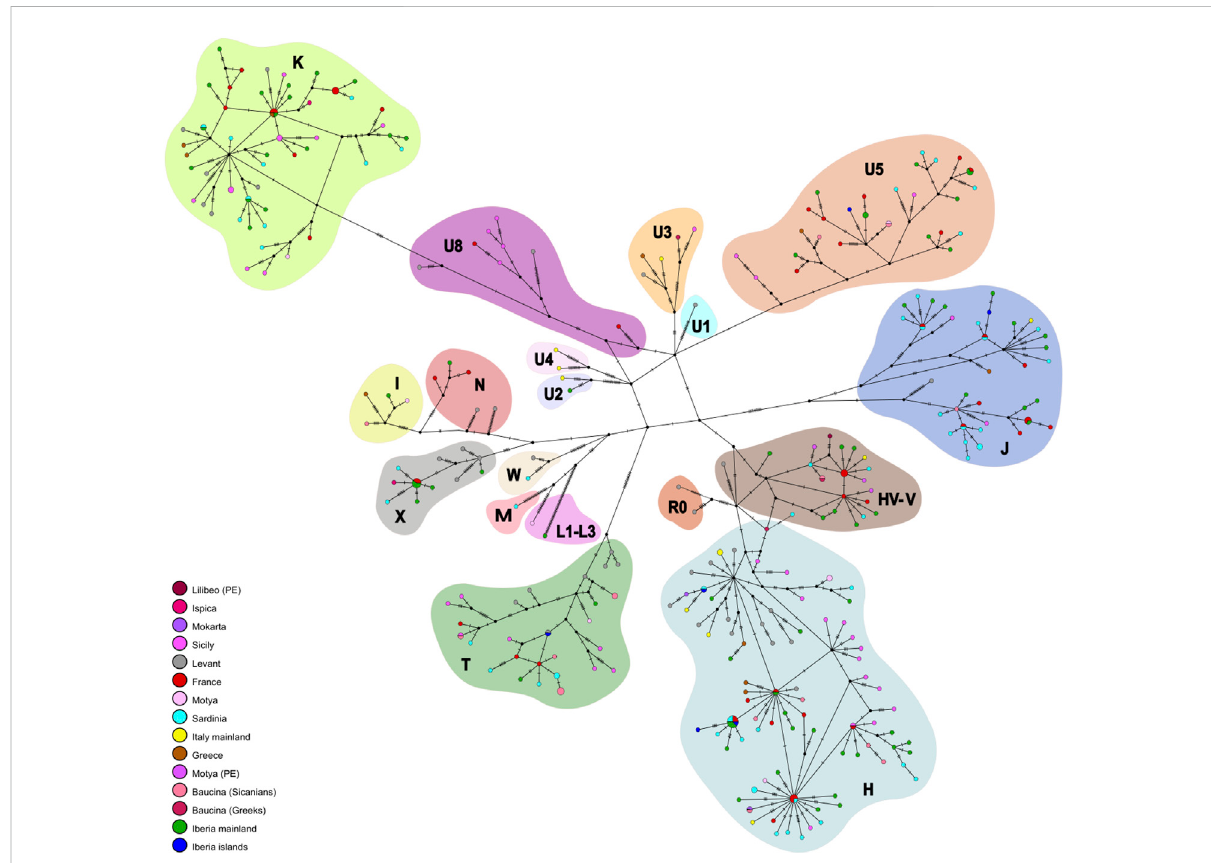
FIGURE 3 Mitochondrial genetic structure of ancient Sicily. Median joining network. Phylogenetic network based on nucleotide variation in the complete mitochondrial